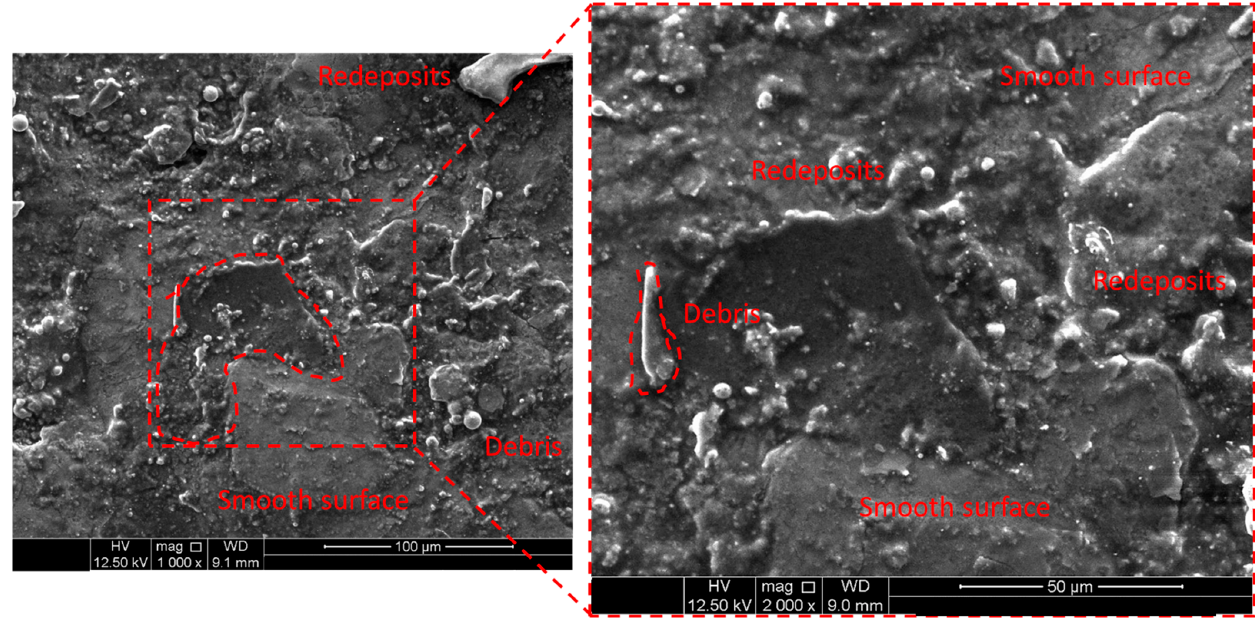
Figure 10. Surface morphology of kerosene-mixed S-60 dielectric at 25 g/L, pulse ON:OFF time of 50:100 µSec, and using graphite electrode.